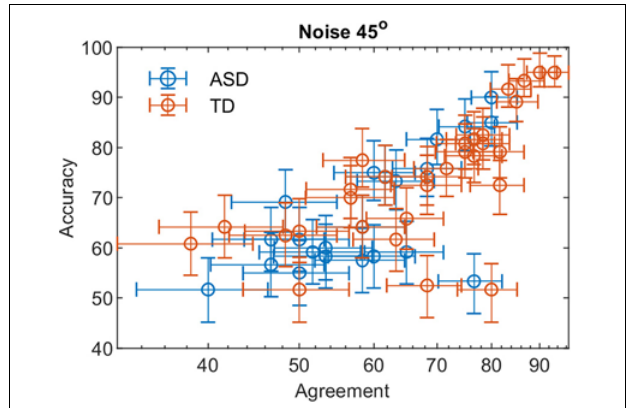
FIGURE 4 | The percent correct responses and the proportion of agreement in a double-pass experiment at 45 ◦ added external noise for the two groups with different development.